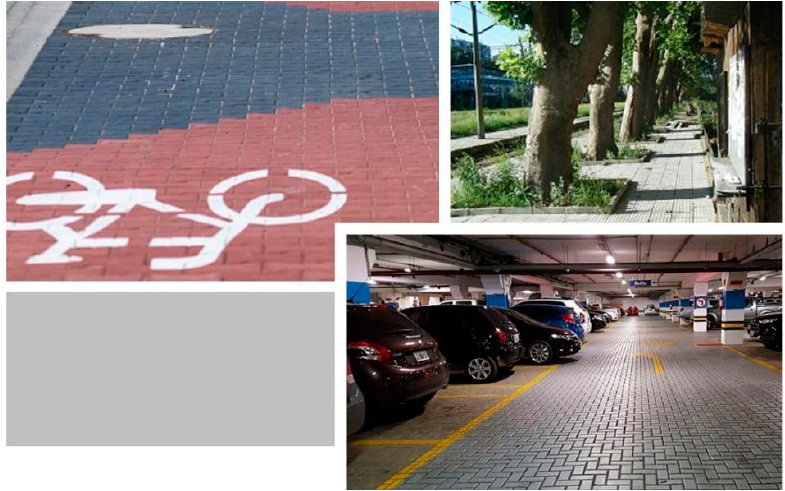
Figure 1. Paving blocks for pedestrian or very-light traffic applications.